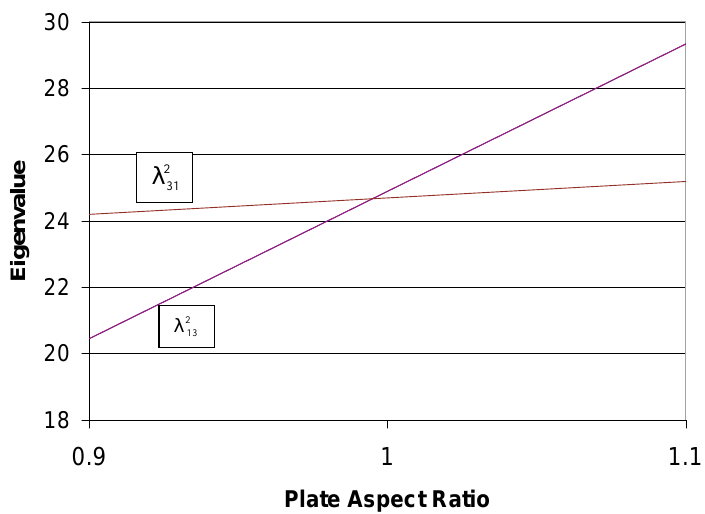
Fig. 1. Eigenvalues of rectangular membrane ( ε = 0 ,λ 2 13 ,λ 2 31 ).